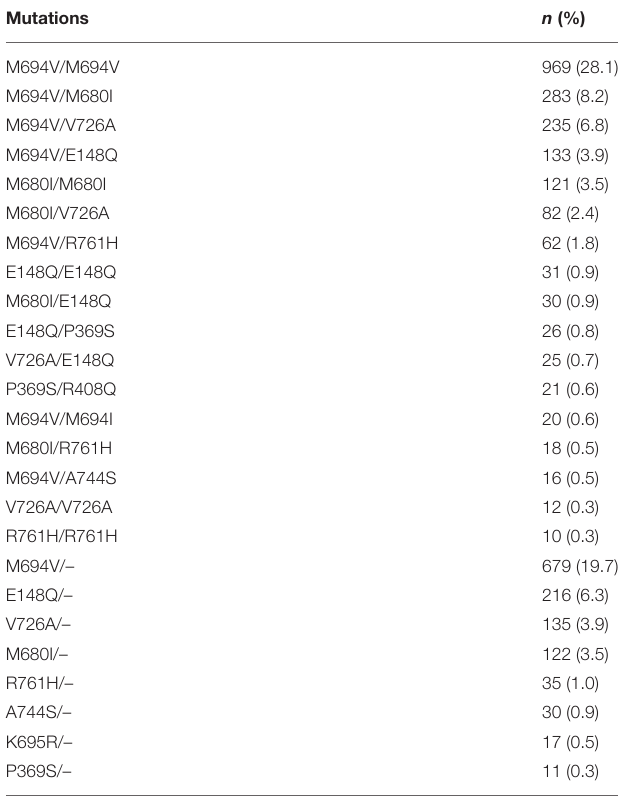
TABLE 2 | The most common mutations in the familial Mediterranean fever cohort.